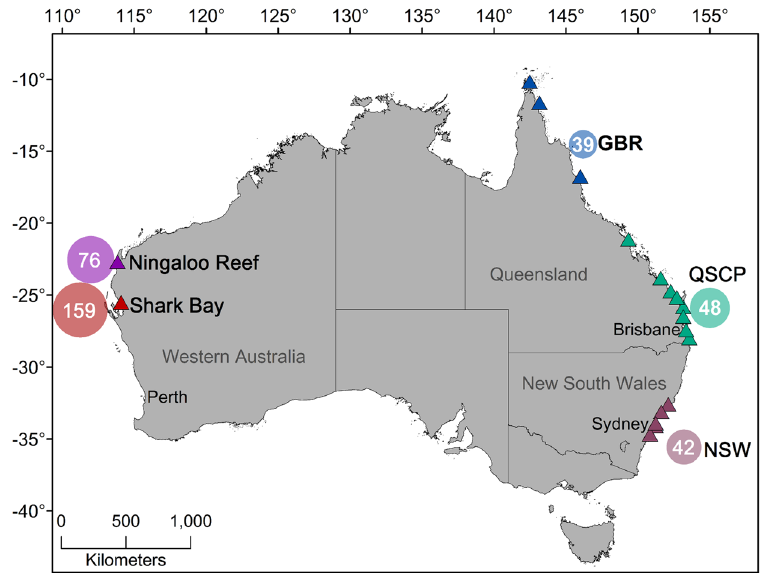
Figure 1. Map showing the study locations across Australia and sampling sites within each region in colour coded triangles. Circles represent relative and total sample size for each dataset. GBR = Great Barrier Reef, QSCP = Queensland Shark Control Program, NSW = New South Wales. Map was created with ArcGis 10.3 (http://www.esri.com/).